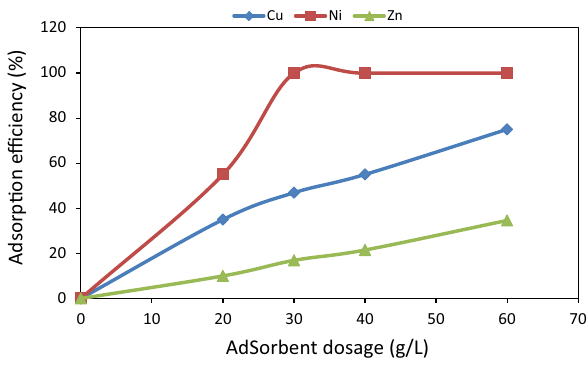
Fig. 2 Adsorption of heavy metals (copper, nickel and zinc) on VAS-I